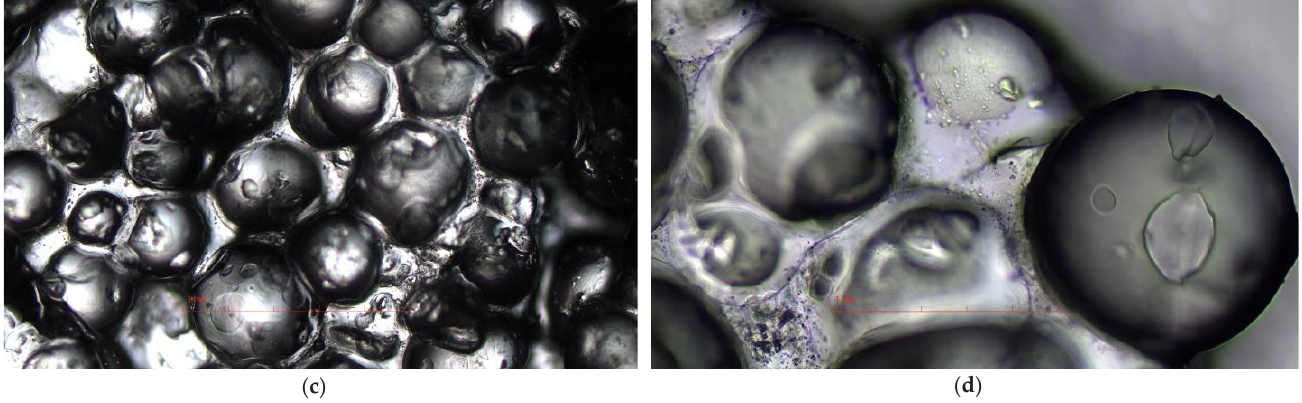
Figure 4. Optical microphotographs of the swollen R1HG-3c [( a , b ) (using a 4 × objective)] and R1HG-4b [( c ) (using a 4 × objective) and ( d ) (using a 10 × objective)].